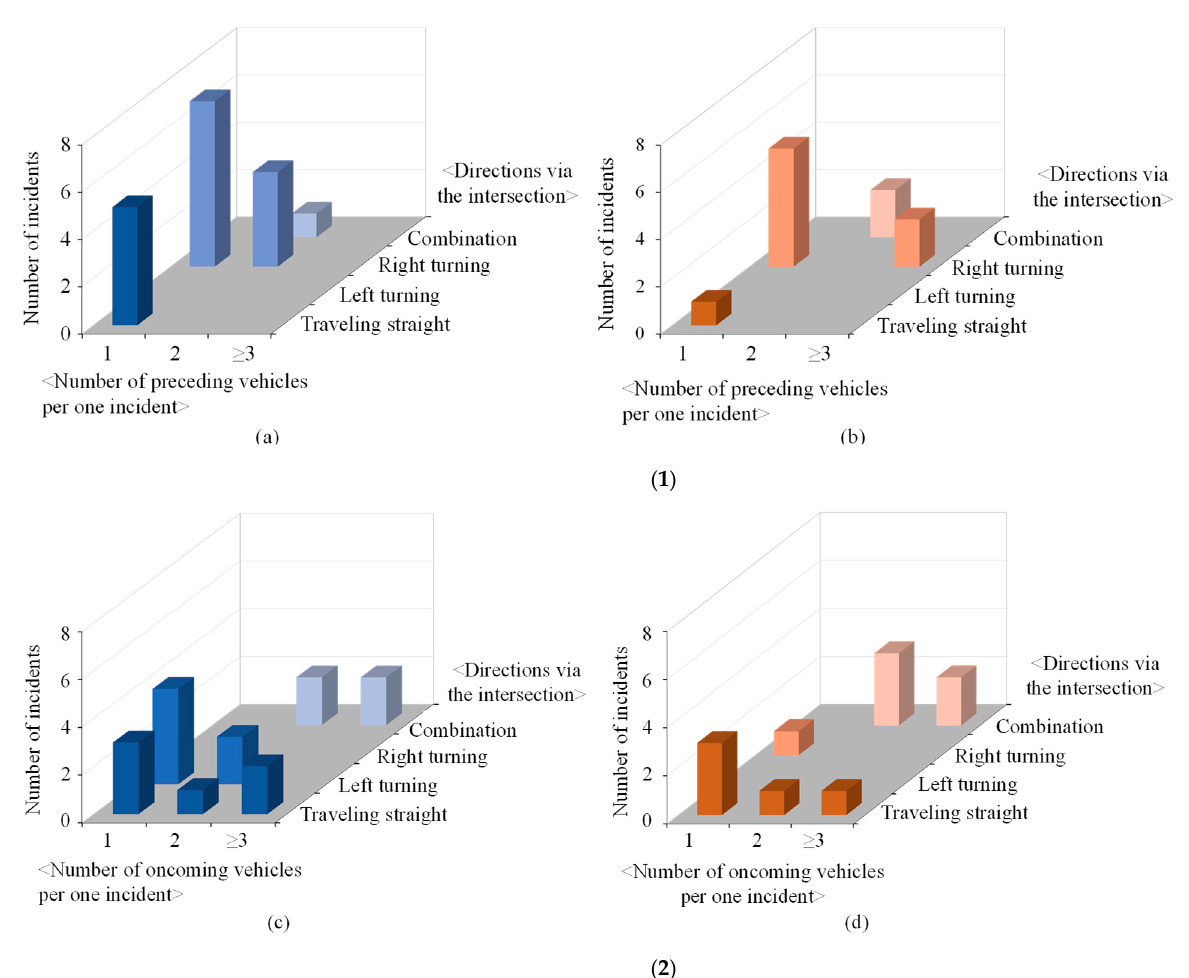
Figure 6. Relationship of number and travel directions through the intersection of preceding vehicles or oncoming vehicles in each incident: ( 1 ) Preceding vehicles; ( a ) Left-Pedestrian ( n = 17); ( b ) Right-Pedestrian ( n = 10); ( 2 ) oncoming vehicles; ( c ) Left-Pedestrian ( n = 16); ( d ) Right-Pedestrian ( n = 10).